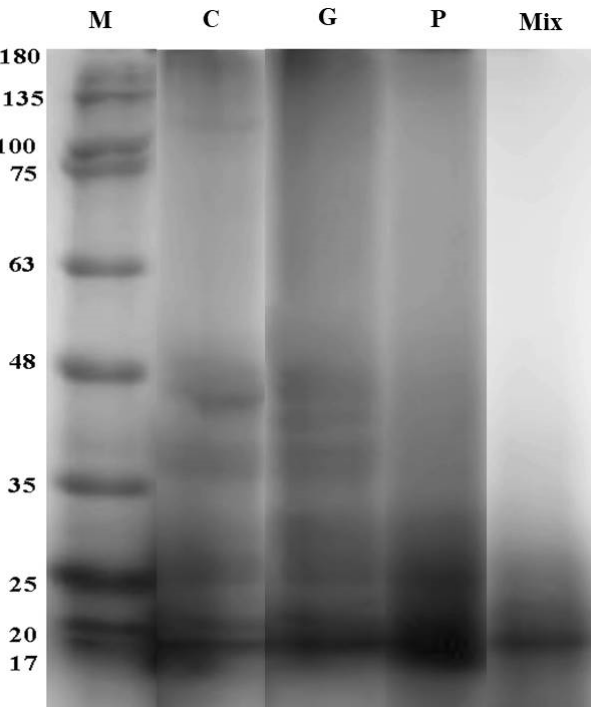
Figure 7. Electrophoretic pattern of camel semitendinosus muscle. M: protein marker; C: control; G: ginger extract; P: papain-enzyme powder; Mix: a mixture of ginger and papain. G: ginger extract; P: papain-enzyme powder; Mix: a mixture of ginger and